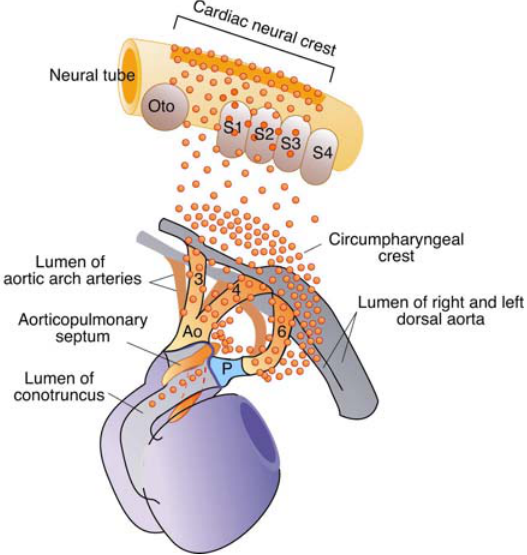
FIGURE 5. Schematic representation of migration of the CNC to the circumpharyngeal ridge, caudal pharyngeal arches (third, fourth, and sixth), and OFT prior to asymmetrical remodeling of the aortic arch arteries. Note that some of the CNC migrate in and surround the nascent aortic arch arteries, while others continue to migrate and eventually colonize the aorticopulmonary septum. Abbreviations: S1, S2, S3, S4, somites 1–4; Oto, otic vesicle. (From Kirby[170], with